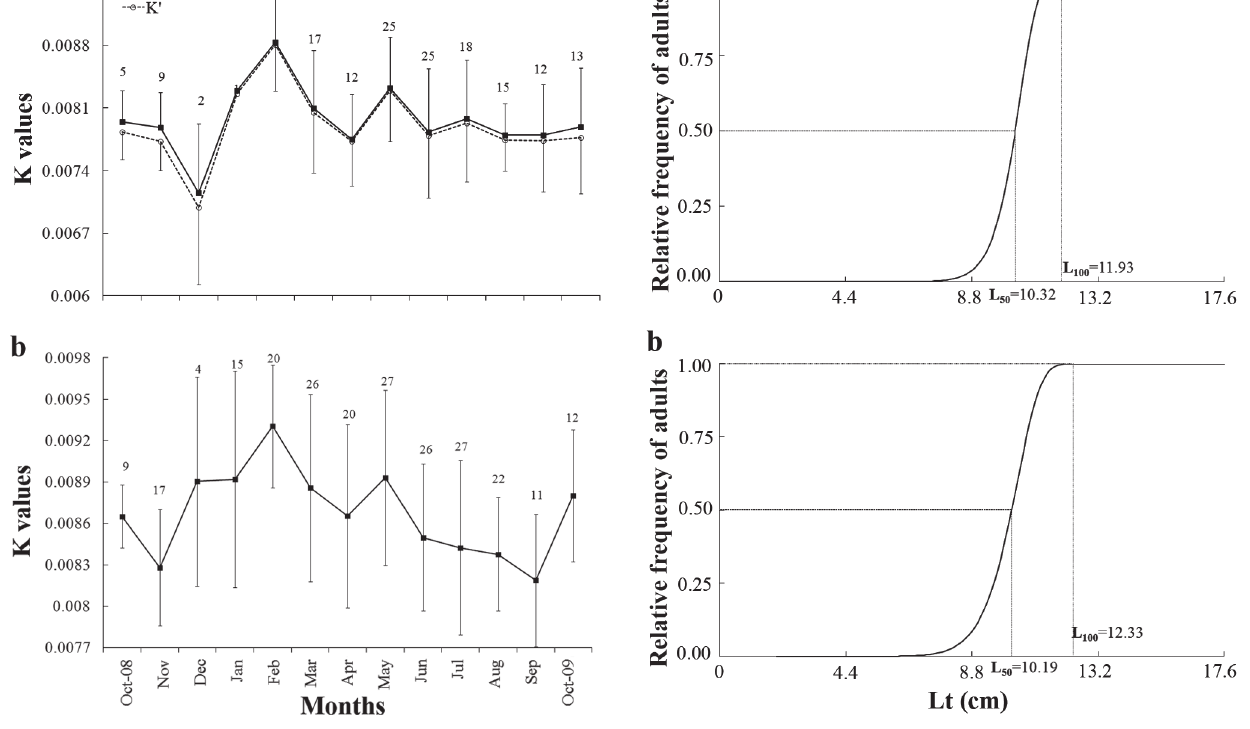
Fig. 7. Monthly mean value of the total condition factor (K) and the somatic condition factor (K’) of females ( a ) and the total condition factor of males ( b ) of Etropus crossotus in the shallow infralittoral areas of the Paranaguá Estuarine Complex. The error bars correspond to the standard deviation. The numbers indicated above the error bars refer to absolute frequency.